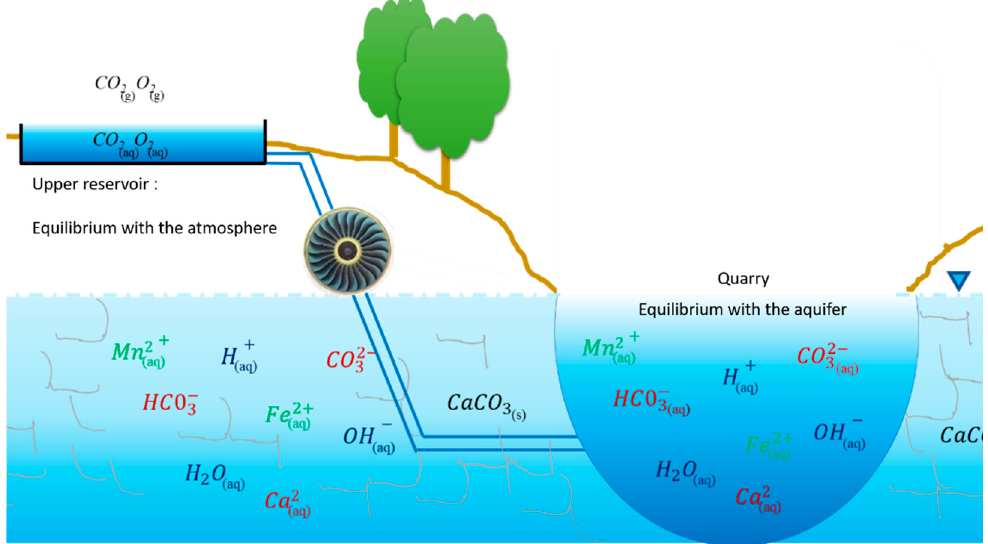
Figure 5. Schematization of the hydrogeochemical model.